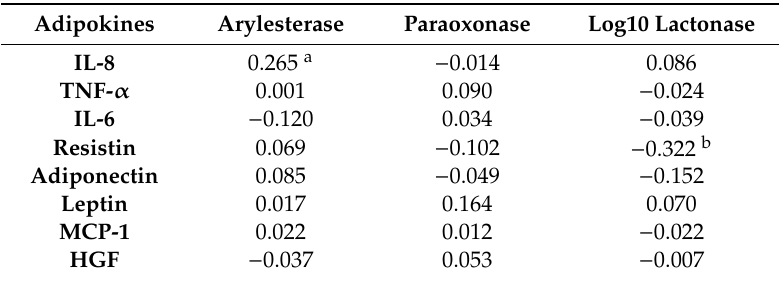
Table 2. Correlation coe ffi cient between PON1 activities and adipokines.